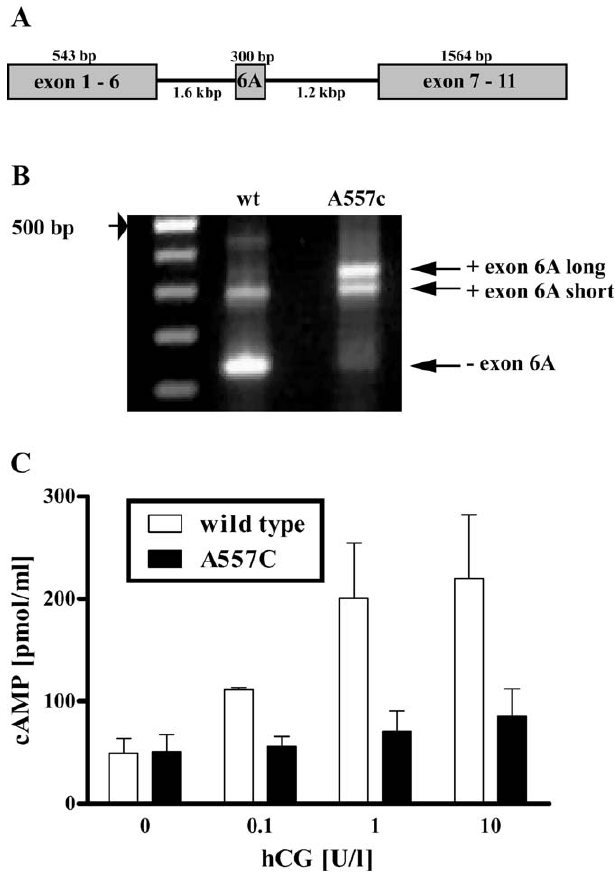
Figure 7. The A557C Mutation Abolishes LHCGR Response to hCG (A) Minigenes were generated by ligating together the LHCGR cDNA from exons 1–6, the genomic DNA fragment encompassing exon 6 to exon 7 of the LHCGR gene from a patient carrying the A557C mutation and one control (wild type), and the LHCGR cDNA from exons 7–11. (B) The constructs were cloned into the pTarget expression vector and transiently transfected in COS7 cells. RT-PCR of the region exon 6 to exon 7 revealed the predominant expression of the LHCGR mRNA lacking exon 6A (wt) for the wild-type LHCGR , while the A557C mutation led to predominant inclusion of exon 6A short and long (A557C). Signal transduction studies were performed as follows: Transfection efficiency was monitored by Renilla luciferase activity. Cells were stimulated by hCG for 3 h and extracellular cAMP was measured by RIA. Results of